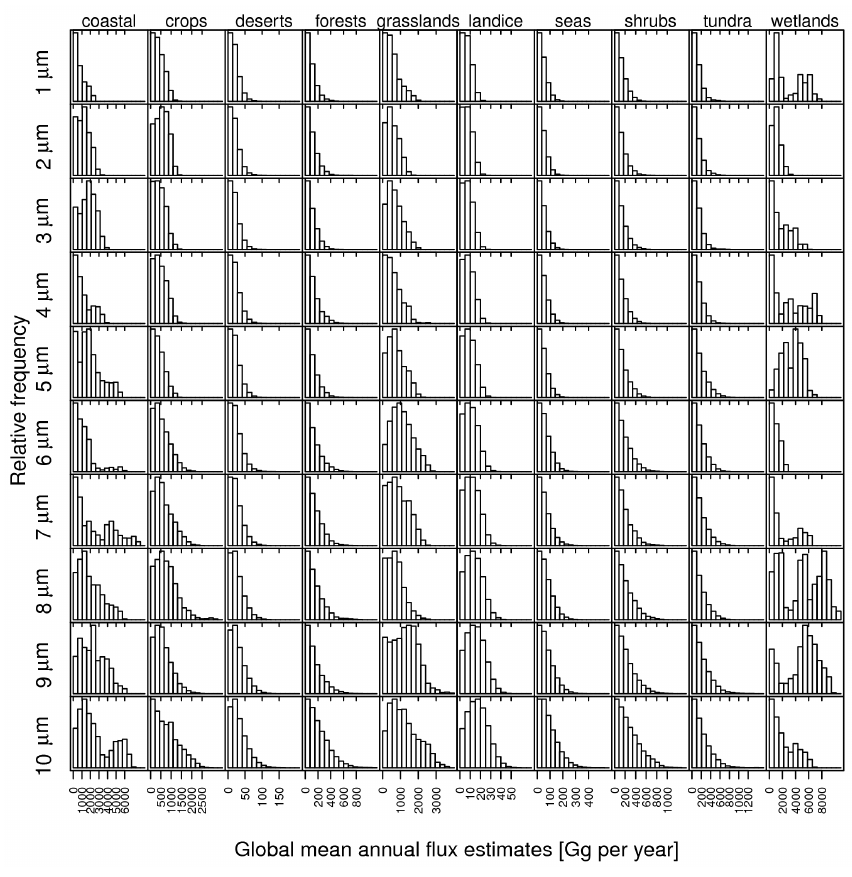
Fig. 2. Histograms of the Monte Carlo sample of flux estimates for each ecosystem and particle sizes from 1µm to 10µm in 1µm intervals. Here for CCN-ACTIVE particles in PRIOR-POS, with Gaussian data uncertainty and a prior positivity constraint on fluxes.